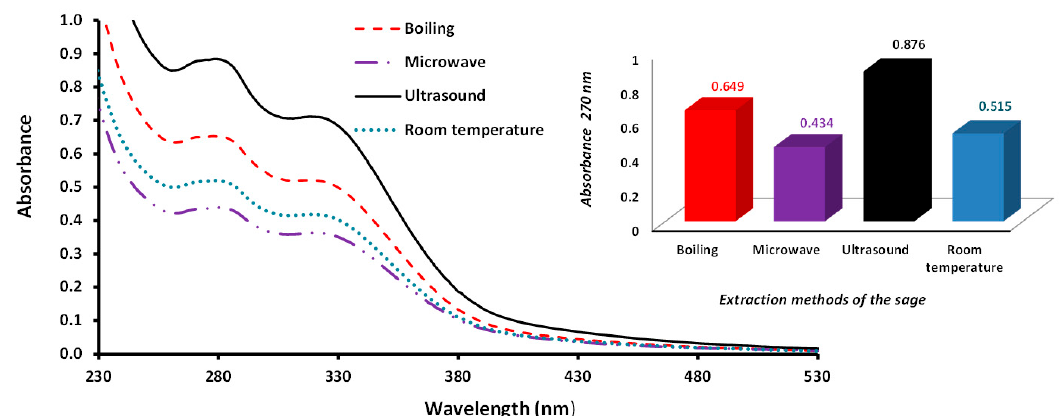
Figure 4. Evolution of absorption curves according to the wavelength and comparison of the absorption levels from λ max for the sage supernatants activated by the four conditions.